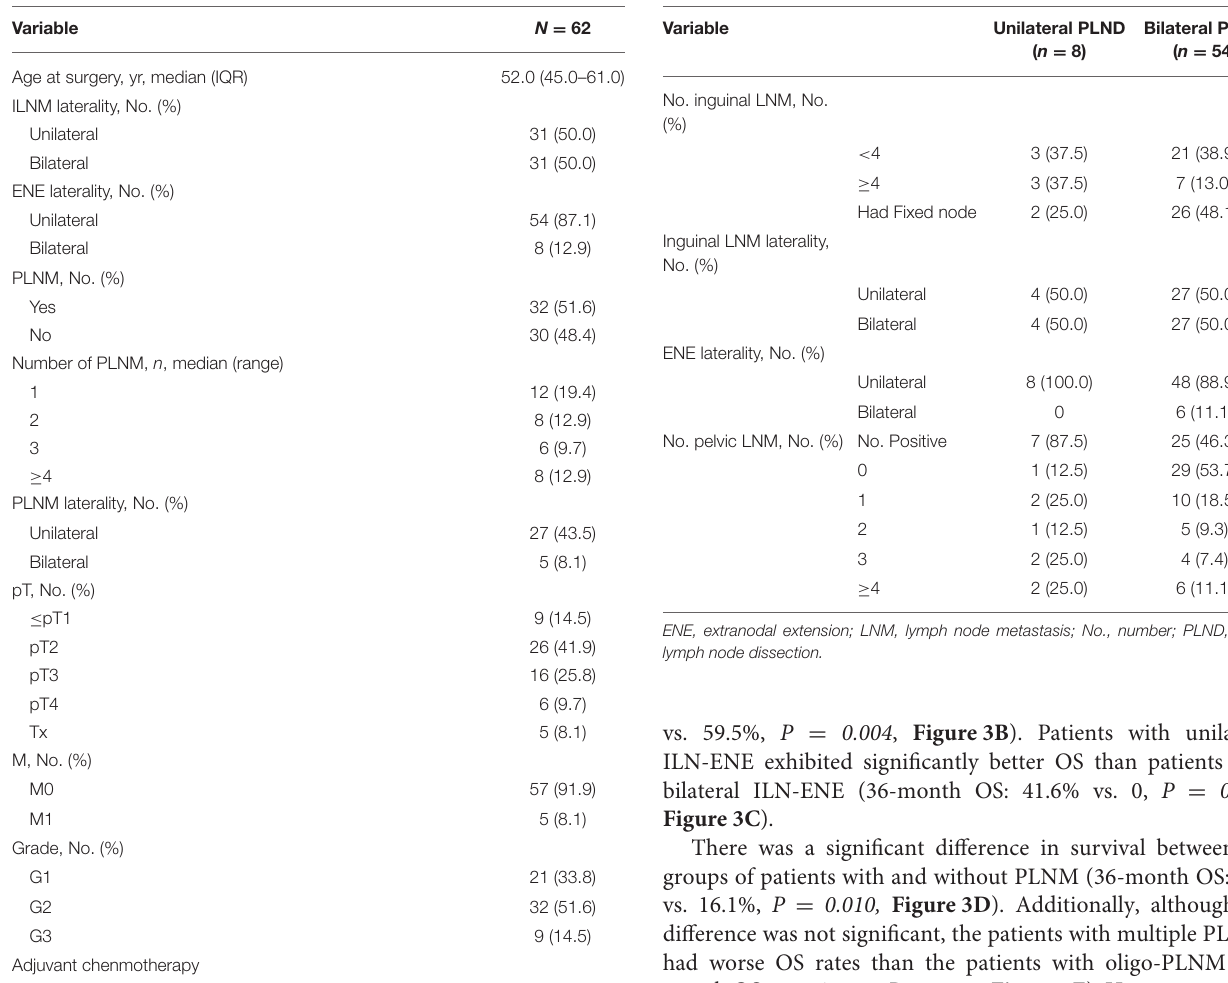
TABLE 2 | Baseline characteristics of the